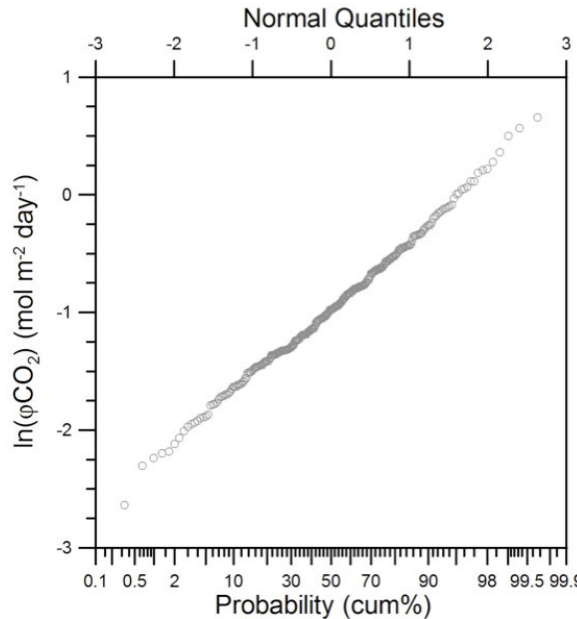
S–CH –H ternary diagram for the Ermeta and Acqua Figure 4. H 2 4 2 Passante gases and the Mt. Amiata gas discharges (by Tassi et. al. [2009]).